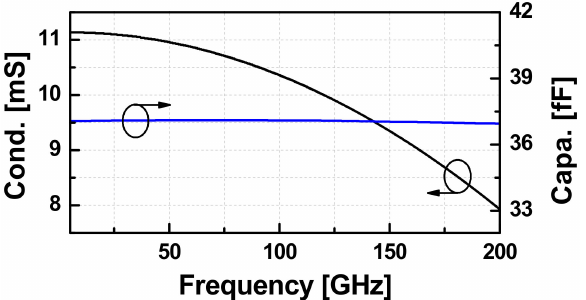
Figure 4. The small-signal extracted capacitance ( C ccp ) and negative conductance ( G ccp ) of a CCP with an NMOS the size of 32 µ m versus frequency.